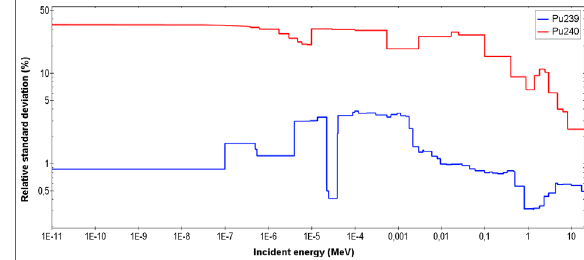
Figure 2. Relative standard deviation of 239 Pu and 240 Pu fission cross section in JEFF-3.3.